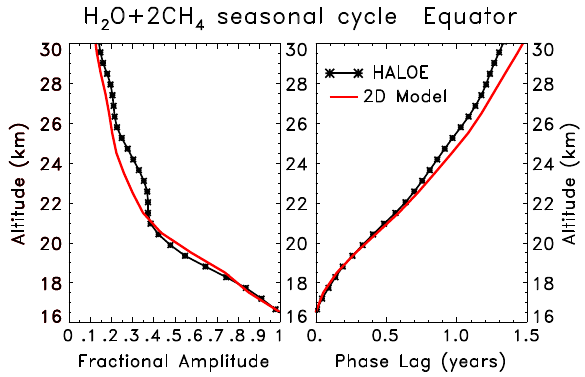
Fig. B8. Equatorial profiles of the amplitude and phase lag of the seasonal cyle in the quantity H 2 O + 2CH 4 from UARS/HALOE (black asterisks) and the 2-D model (red curve). Amplitudes are relative to the values at 16.5km, and the phase lag is defined to be zero at 16.5km. Values are averaged over 1994–2004 for both the 72 data and